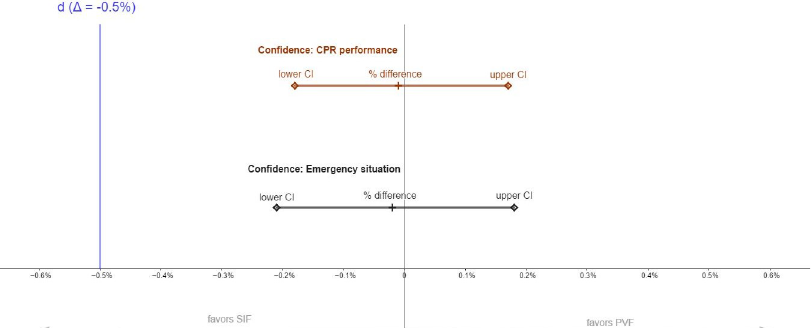
Fig 5. Non-inferiority results for self-reported confidence. Notes . Proportion (%) difference, lower and upper 95% CI for both confidence regarding CPR performance and confidence regarding an emergency situation. The line marked “d” indicates the non-inferiority margin. Values < 0 favor SIF and values > 0 favor PVF. Significant non- inferiority is given when the lower CI lies above d. CPR: Cardiopulmonary resuscitation.